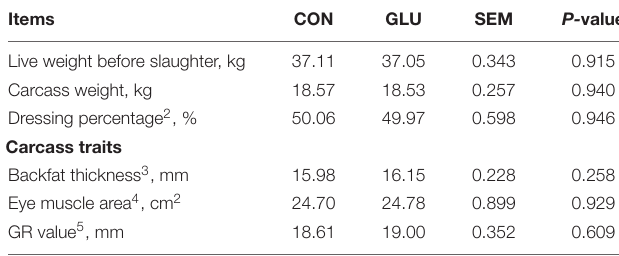
TABLE 3 | Effects of glutamate supplementation on carcass traits of heat stressed Hu sheep ( n = 6) 1